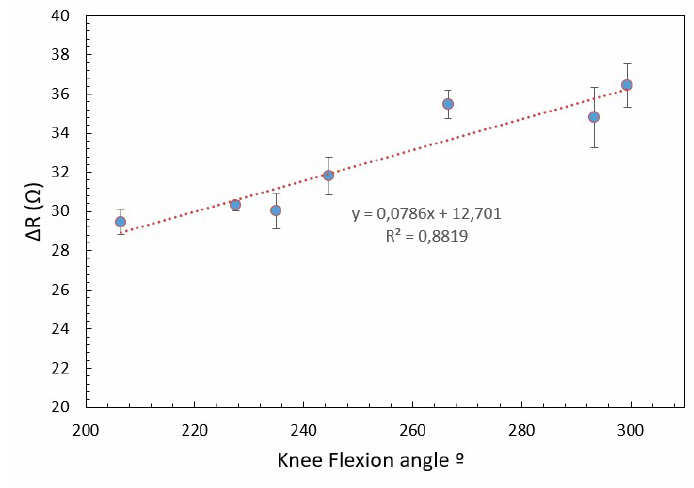
Figure 9. Measured resistance for different knee